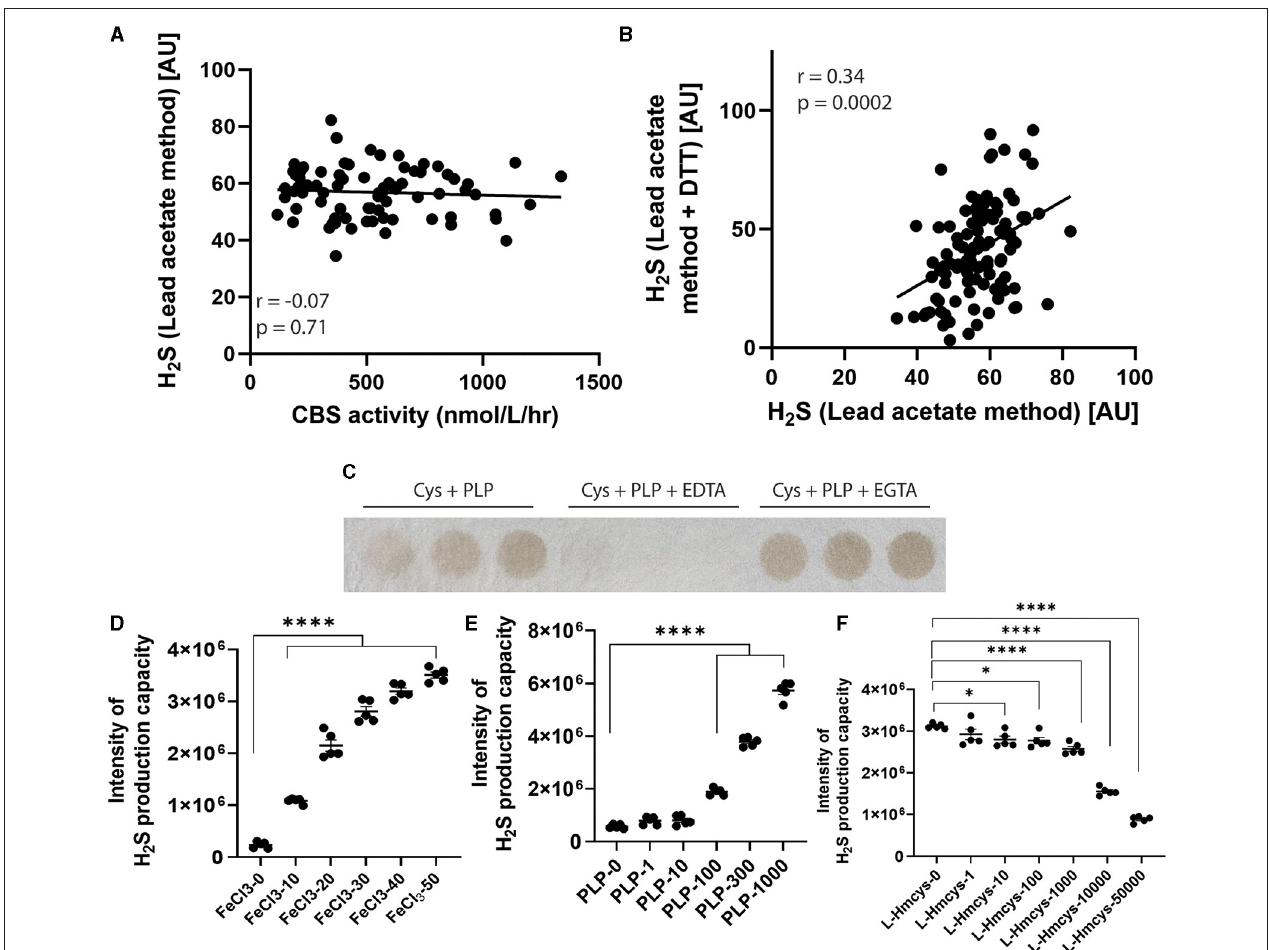
FIGURE 3 | Mechanisms of H 2 S release from plasma. (A) Correlation between plasma cystathionine-beta synthase activity and plasma H 2 S release. (B) Correlation between plasma H 2 S release performed under protein non-denaturing (x-axis) and protein denaturing (y-axis) conditions. (C) H 2 S release from plasma when incubated with PLP, PLP + EDTA or PLP + EGTA. (D) In vitro H 2 S release performed using cysteine and increasing concentration of FeCl 3 , (E) PLP or (F) homocysteine ( n = 5 reactions per condition). * p < 0.05, **** p < 0.0001 vs. respective 0uM